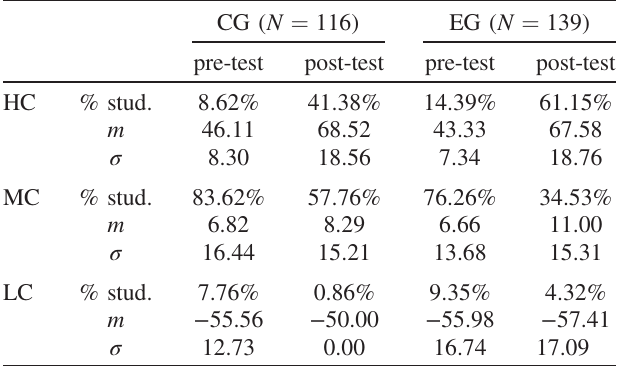
TABLE VIII. Share of students ( % stud.) per group (HC: high conception index group, MC: medium conception index group, LC: low conception index group) based on the pre- and post-test results on the quantum objects ’ properties and behavior scale for CG and EG, respectively. Mean values m and standard deviations σ of the conception indices are provided.